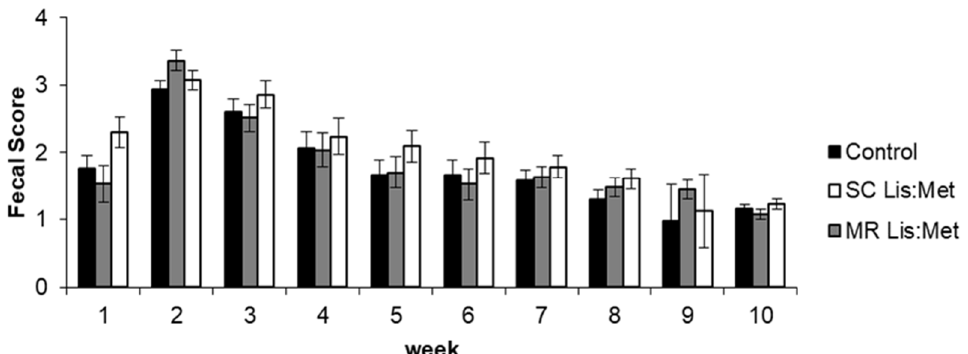
Figure 1. The fecal score of dairy calves in the step-up/step-down feeding system with or without lysine and methionine supplementation in starter concentrate or milk replacer.